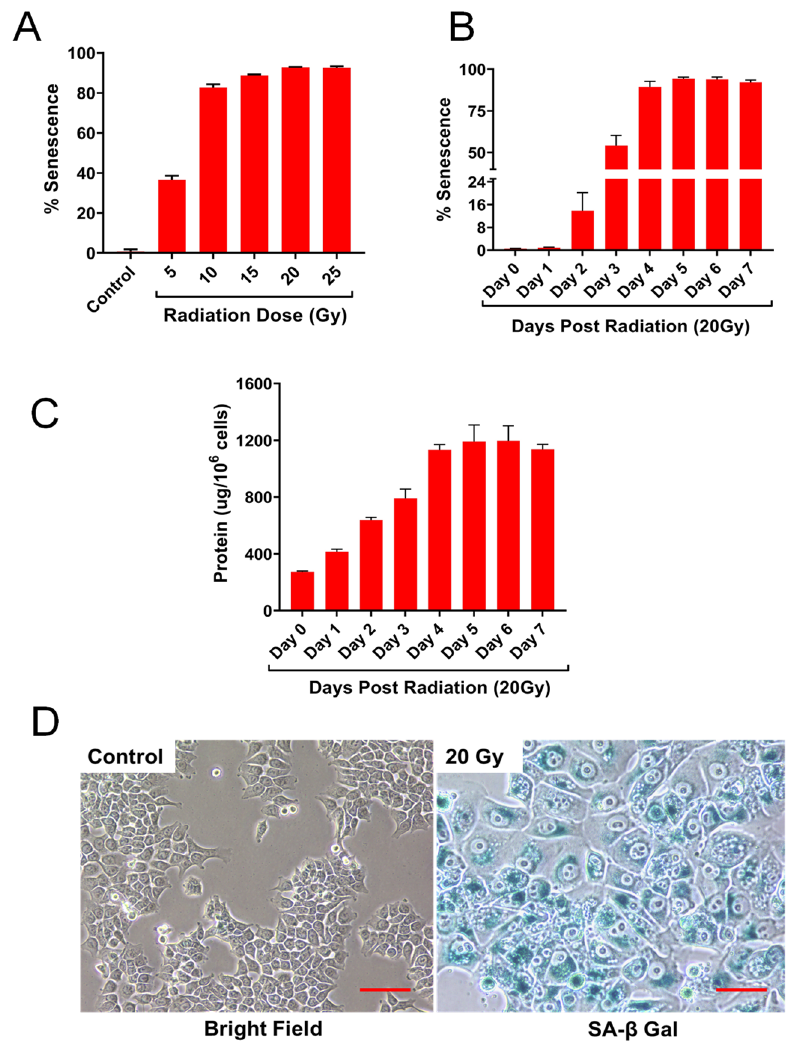
Figure 1. Ionizing radiation induces senescence in human colon cancer cell line, HCT-116. ( A ) Effect of IR dose on senescence in HCT-116 cells. ( B ) Time course of senescence induction in HCT-116 cells after 20 Gy IR treatment. ( C ) Levels of cellular protein at various post-IR days in HCT-116 cells exposed to 20 Gy. Control cells were used on the day of IR but without IR. Results are from one typical experiment with triplicate samples representing at least two other experiments. ( D ) Representative photomicrographs of HCT-116 cells. Cells were fixed and stained for SA-βgal. Red bar represents 100 µM.